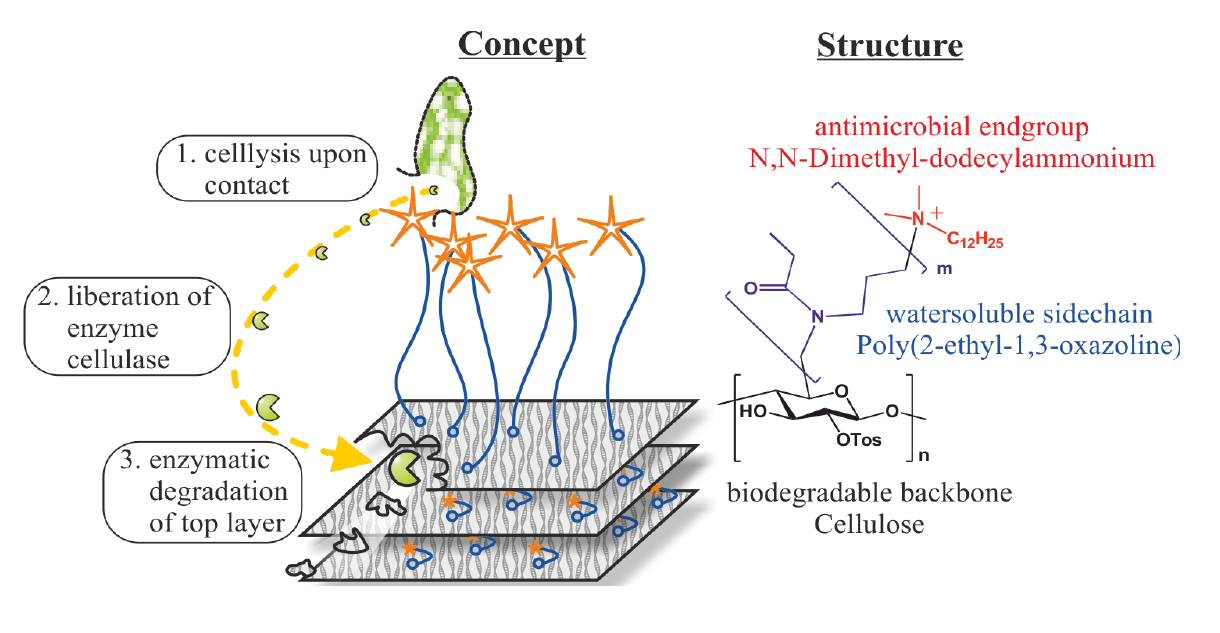
Figure 12. Concept of a cellulose-based coating with an attached biocidal polymer that can be degraded by cellulase. Created according to